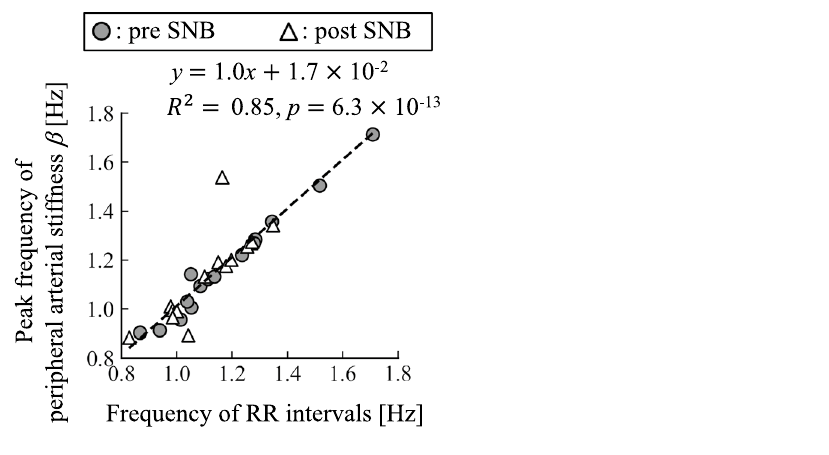
Figure 4. Relationship between peak frequency of peripheral arterial stiffness β and that of RR intervals for all subjects.